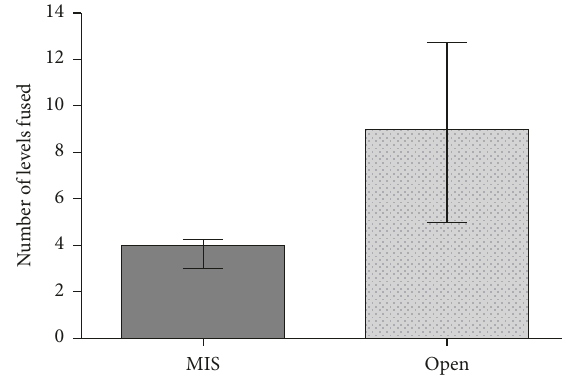
Figure 1: Number of levels fused for patients undergoing MIS approach versus open